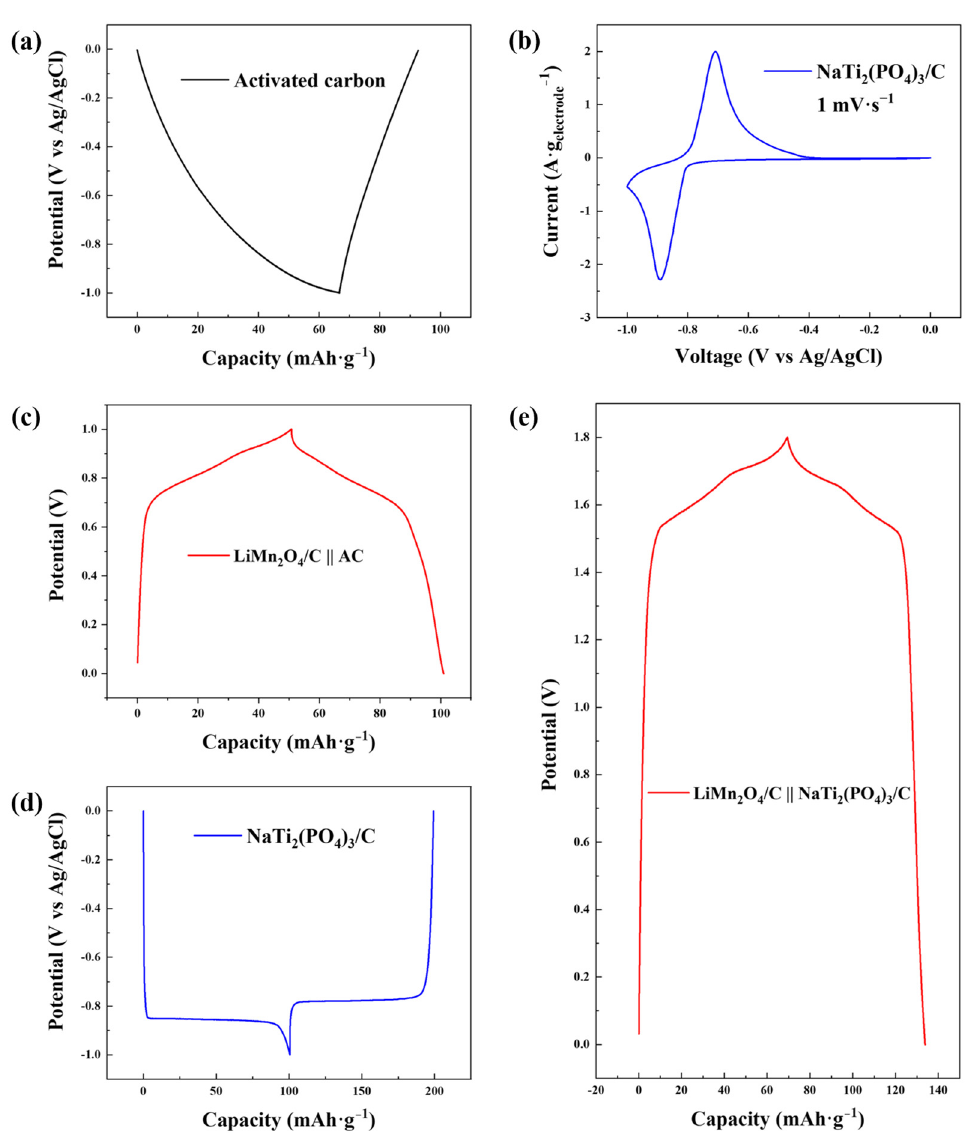
Figure 3. ( a ) GCD profile of AC in 1.0 M NaCl solution with the current density of − 0.1 A·g − 1 with Ag/AgCl as the reference electrode; ( b ) cyclic voltammetry curve of NaTi 2 (PO 4 ) 3 /C in 1.0 M NaCl solution with the scan rate of 1 mV·s − 1 ; ( c ) GCD profile of LiMn 2 O 4 /C in 1.0 M LiCl solution at the current density of 0.1 A·g − 1 with AC as the counter electrode in the two-electrode system; ( d ) GCD profile of NaTi 2 (PO 4 ) 3 /C in 1.0 M NaCl solution at the current density of − 0.1 A·g − 1 with Ag/AgCl as the reference electrode; ( e ) GCD profile of LiMn 2 O 4 /C in a mixed solution (0.5 M LiCl + 0.5 M NaCl) at the current density of 0.1 A·g − 1 with NaTi 2 (PO 4 ) 3 /C as the counter electrode in the two-electrode system.